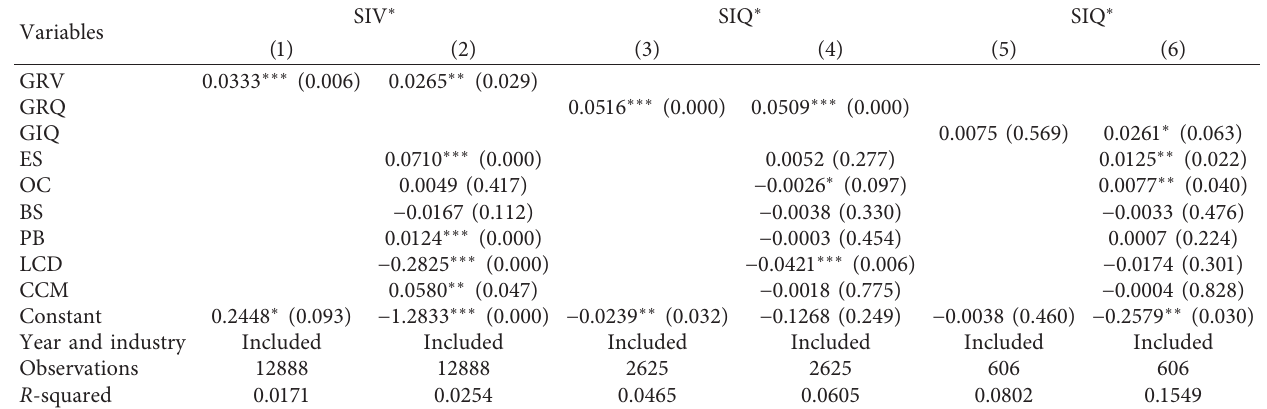
Table 7: Robustness test: replacing the dependent variable.